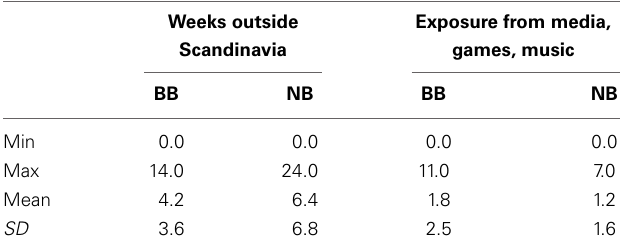
Table 1 | Mean, minimum and maximum values and standard deviations ( SD ) for weeks spent outside of Scandinavia and hours of exposure from media, games and music prior to starting school in the bilingually-based and the native language-based groups. Weeks outside Exposure from